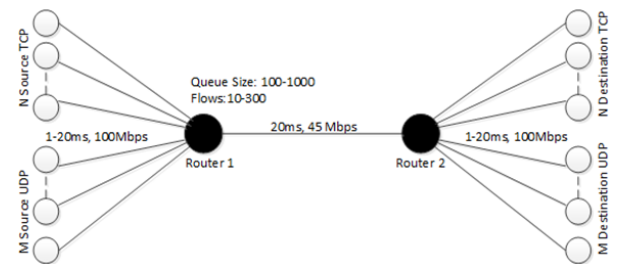
Figure 11. Network simulation